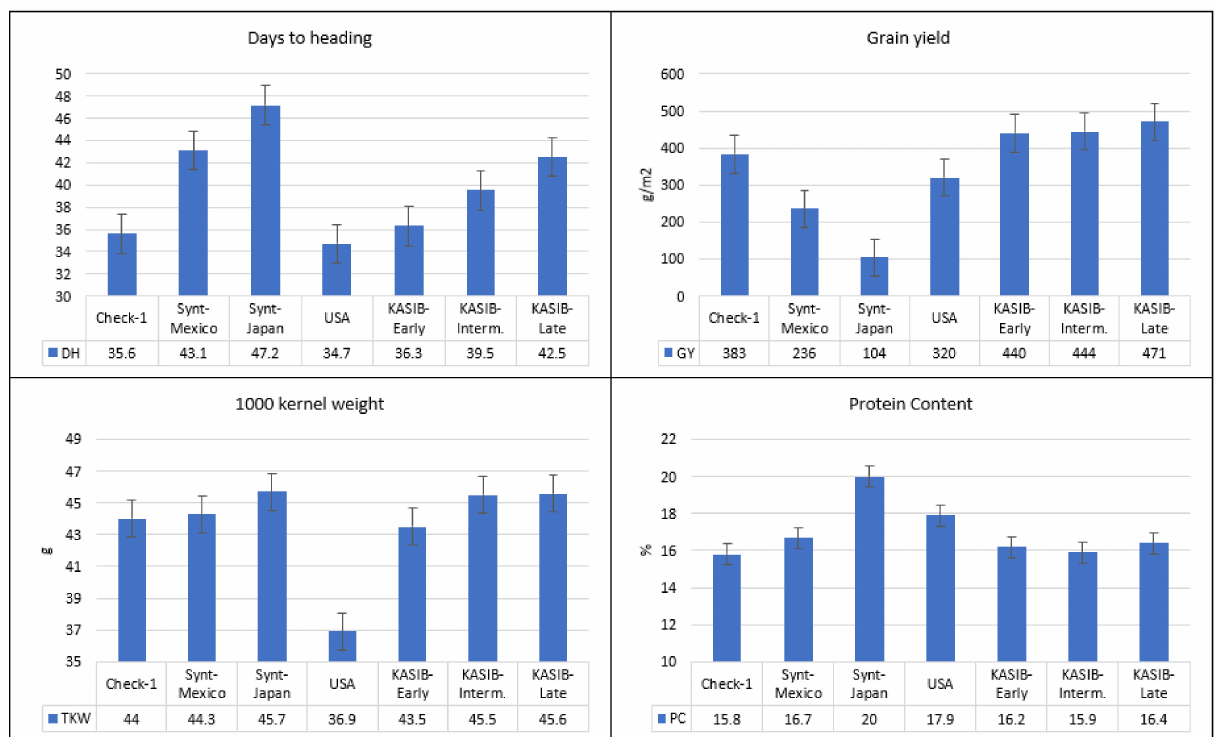
Figure 1. Variation for agronomic traits in different groups of genetic resources, average values for 2017–2018, and bars representing standard error.